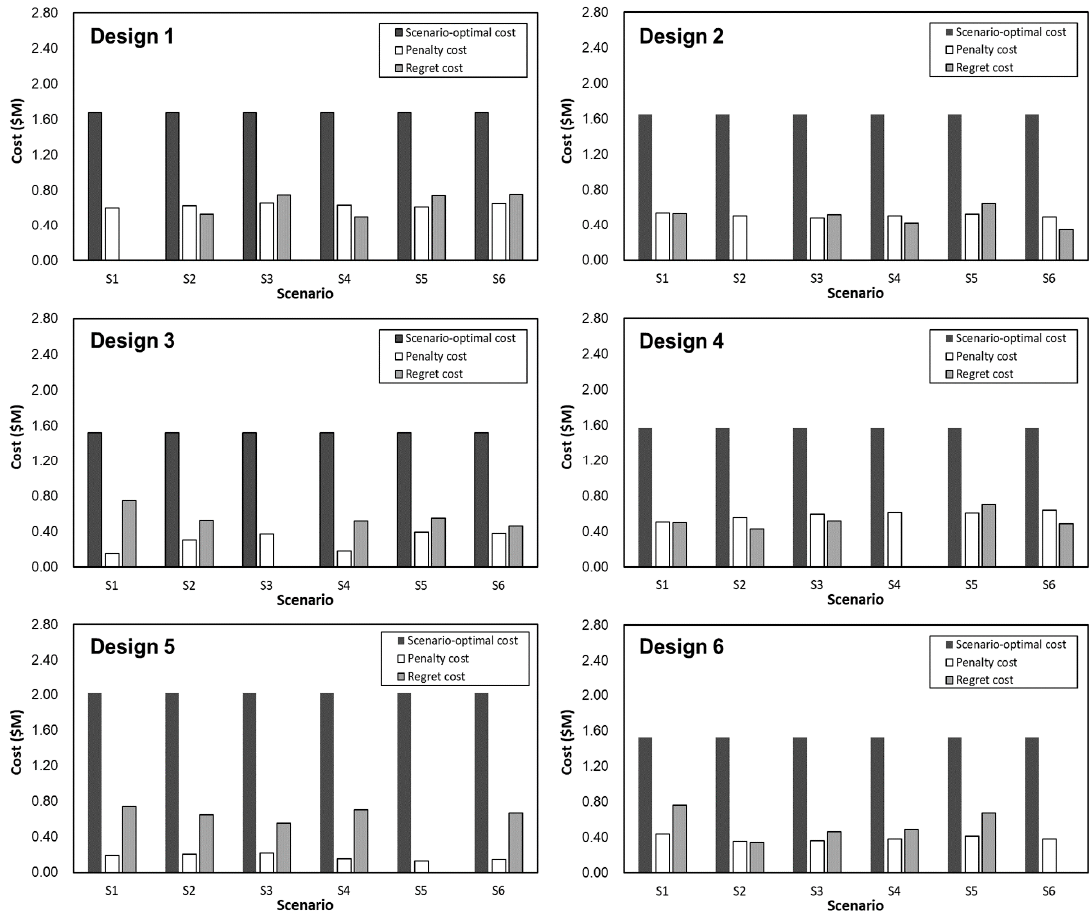
Figure 8. Final total costs of each scenario-optimal solution under future alternative scenarios.